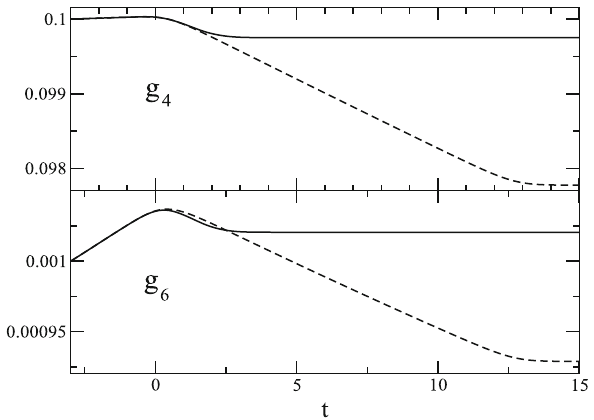
Fig. 3 Flow of g 4 (upper panel) and g 6 (lower panel) with the same boundary values (and the same coding) adopted in the two cases dis- played in Fig. 2, with further boundary values: g 6 = g 8 = 0 . 001 at t = − 3